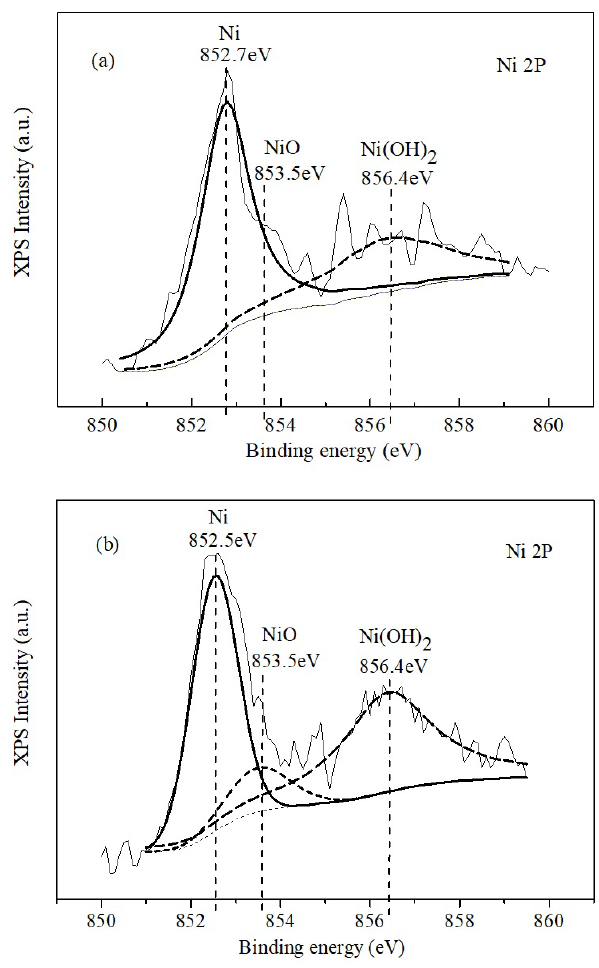
Figure 8. Ni 2p XPS peaks for the passive film after immersing in 7 vol.% HCl solution. (a) ordinary Ni coating. (b) multilayered Ni